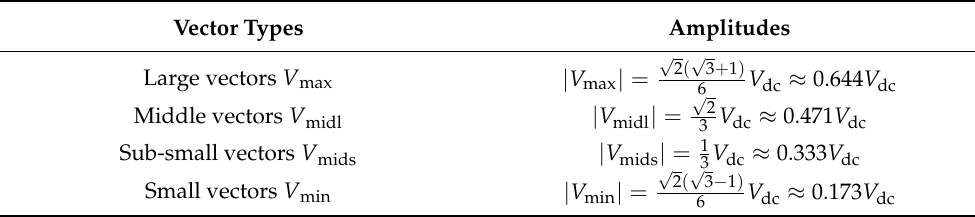
In addition, the same voltage has a contrary mapping location on different subplaces.